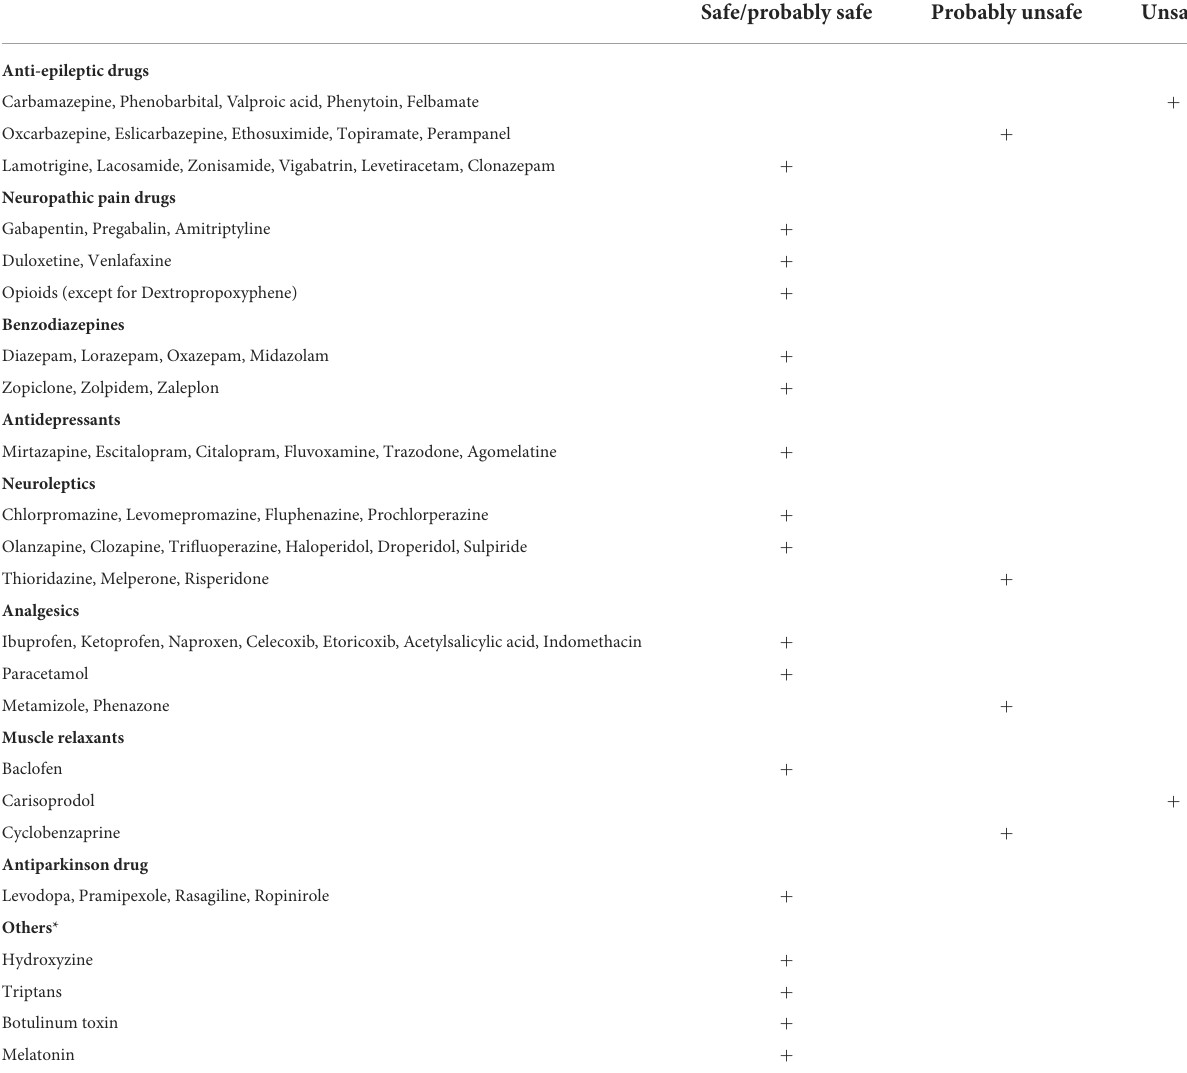
TABLE 1 Safety profiles of commonly prescribed neurologic medications (28).